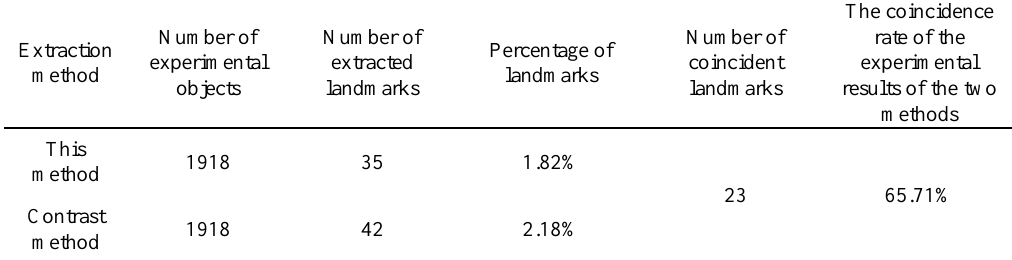
Table 2. Comparison of the experimental results of two